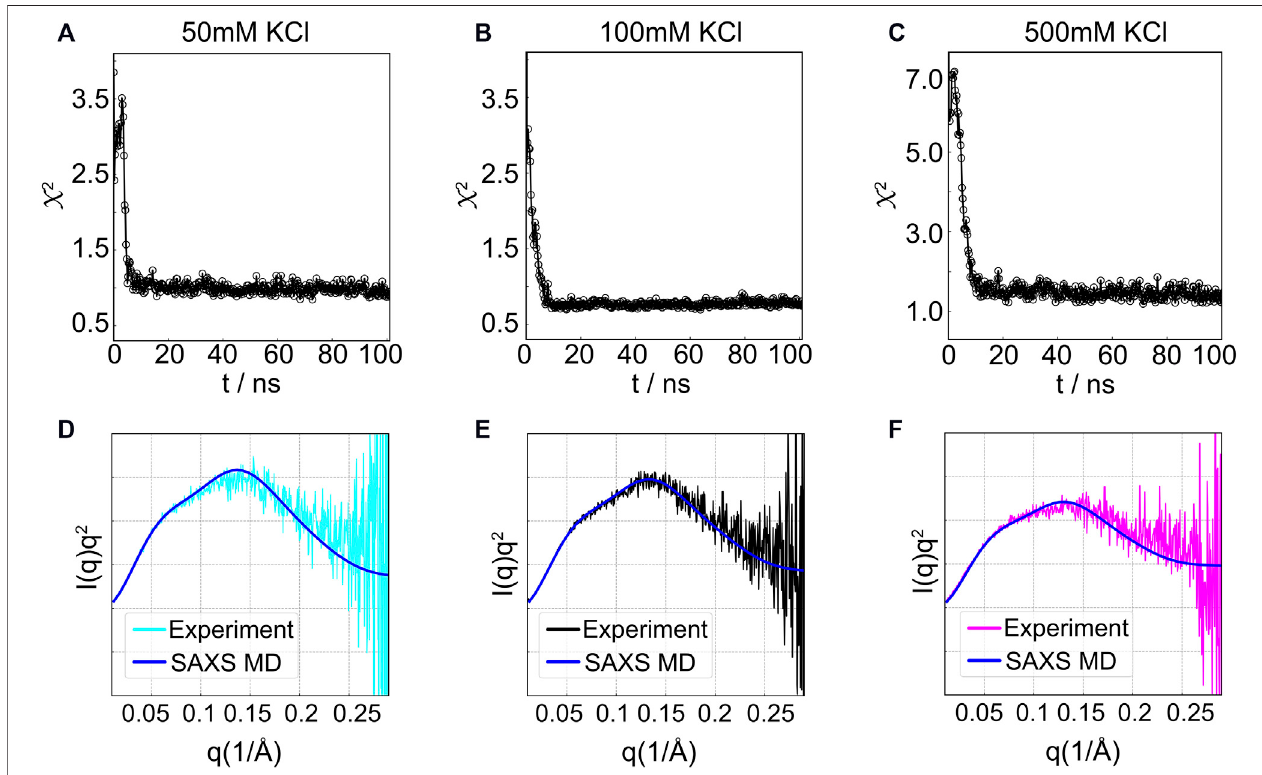
FIGURE 10 | SAXS-driven MD simulation results for the HJH RNA at three concentrations. (A – C) Time evolution of χ 2 for (A) 50 mM, (B) 100 mM, or (C) 500 mM KCl. The asymptotic amplitude of χ 2 indicates the convergence. (D – F) Comparison of the measured SAXS data and the computed SAXS averaged over trajectory after the simulations